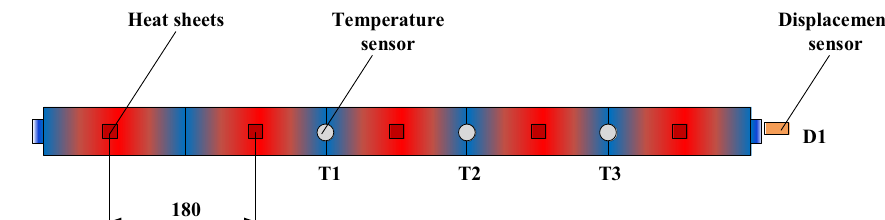
Figure 8: Arrangement of sensors and heating